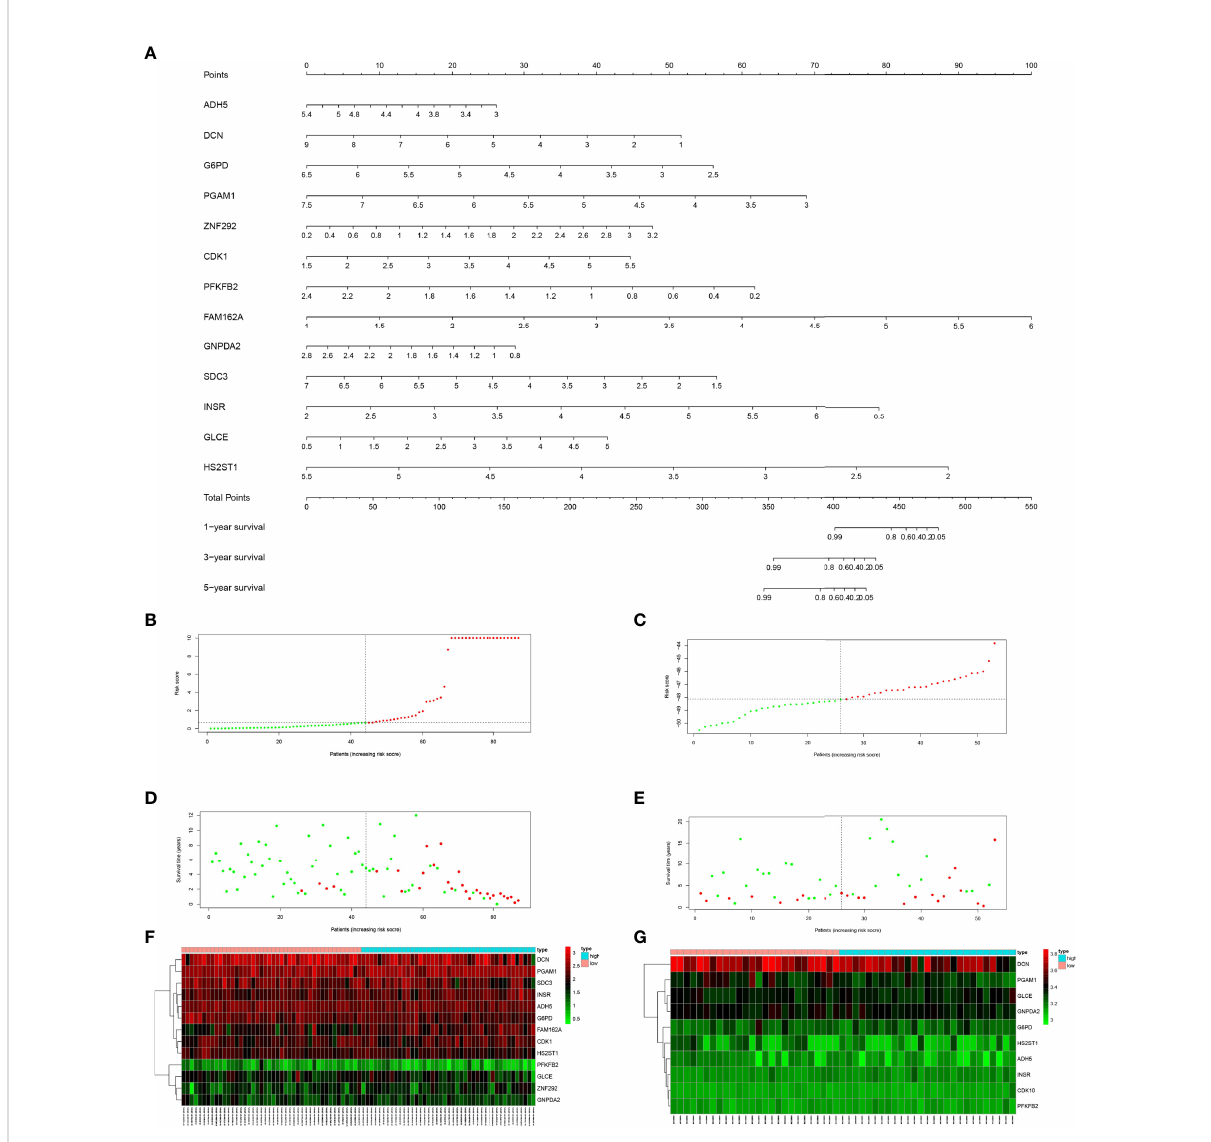
FIGURE 3 (A) Nomogram of prediction model for OS patients. (B) Risk score distribution of low-risk (green) and high-risk (red) in TARGET patients with OS. (C) Risk score distribution of low-risk (green) and high-risk (red) in GSE21257 patients. (D) Scatter plot of survival status of TARGET patients with OS. Red dots (dead); green dots (alive). (E) Scatter plot of survival status of GSE21257 patients in. Red dots (dead); green dots (alive). (F) Expression of risk genes in the high-risk (blue) and low-risk (pink) of TARGET patients with OS. (G) Expression of risk genes in the high-risk (blue) and low-risk (pink) of GSE21257 patients with